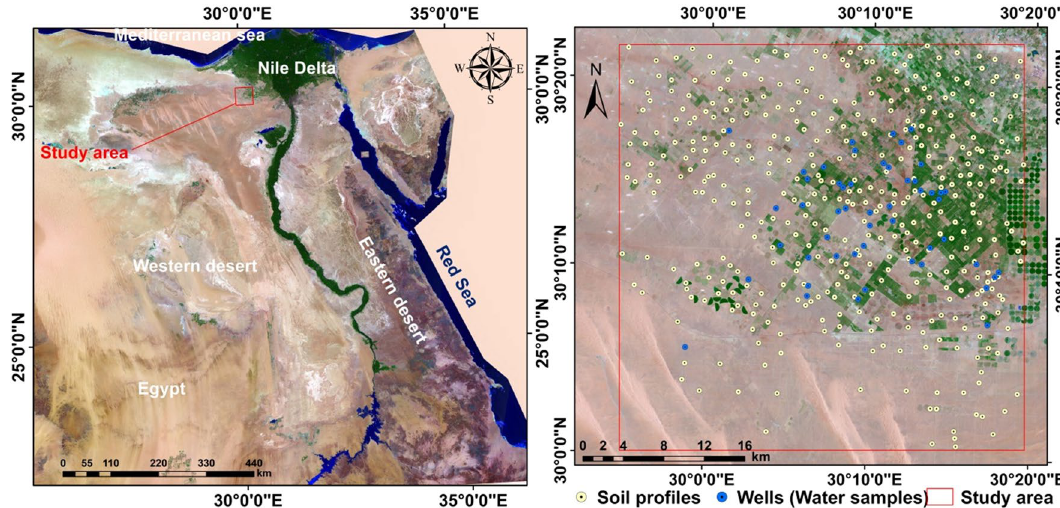
Figure 1. Location of the study area and soil sampling sites.